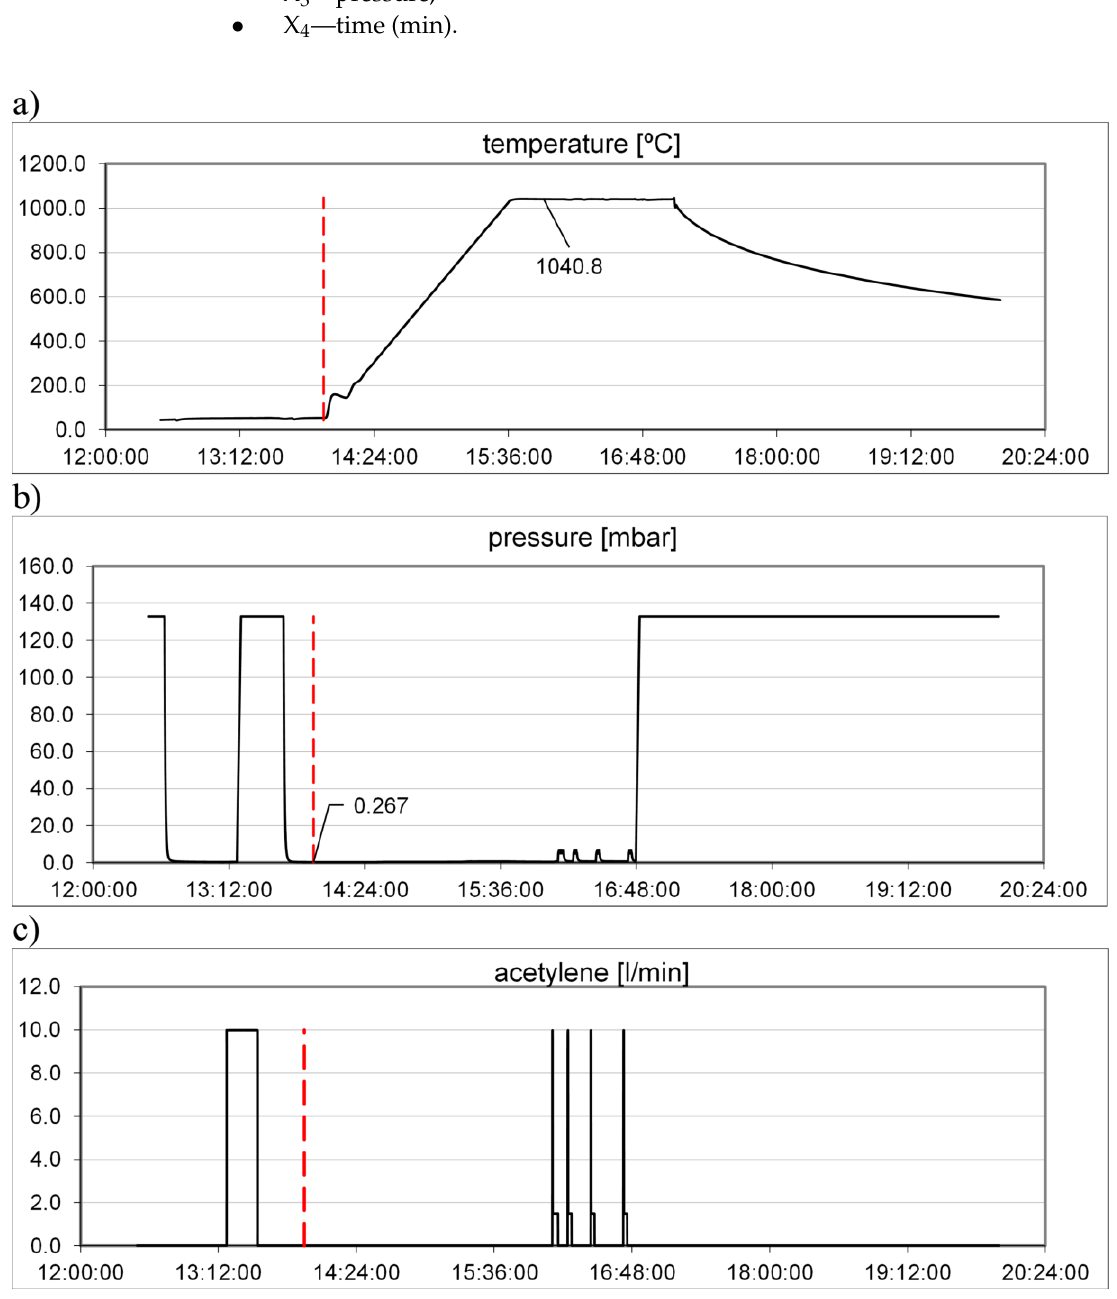
Figure 2. Changes in temperature ( a ), pressure ( b ) and acetylene flow ( c ) during the low pressure carburisation